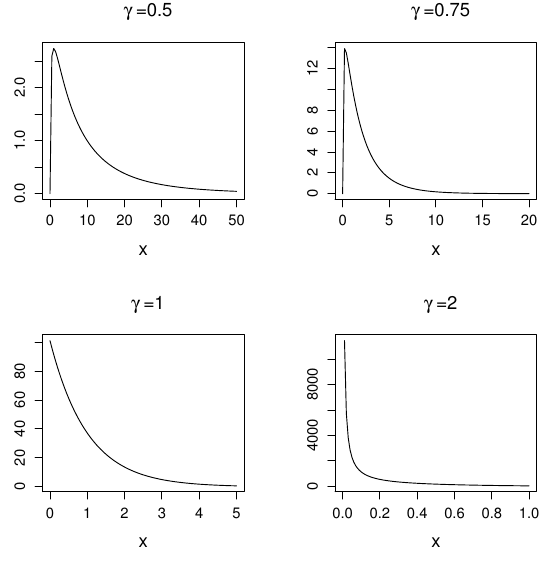
Figure 4. Mean residual life for β = 1 and γ = 0 . 5 , 0 . 75 , 1 ,